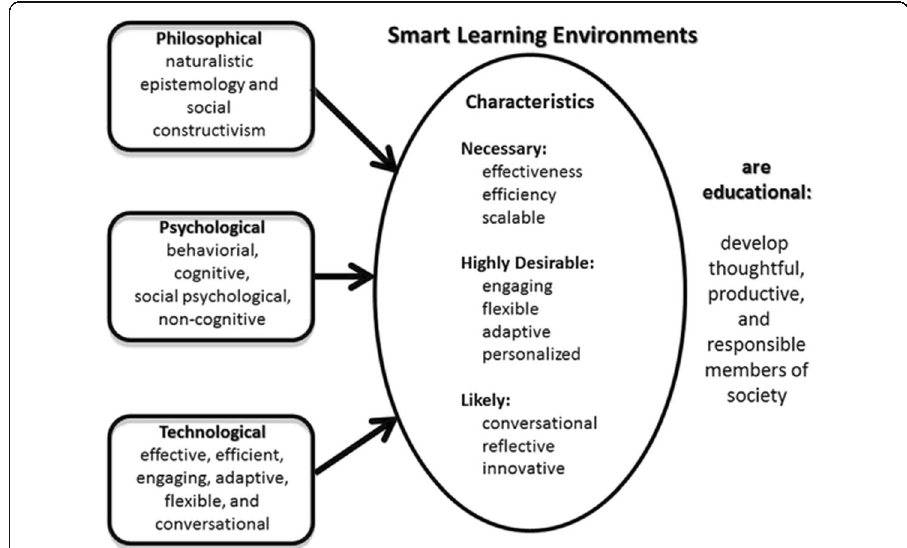
Fig. 2 Spector ’ s preliminary framework for SLE (Spector,